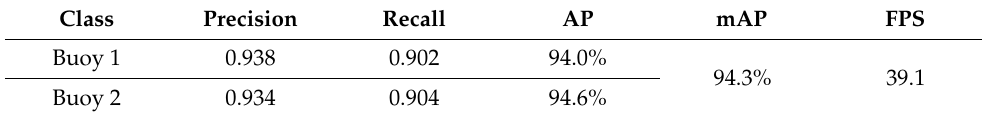
Table 3. Detection results on